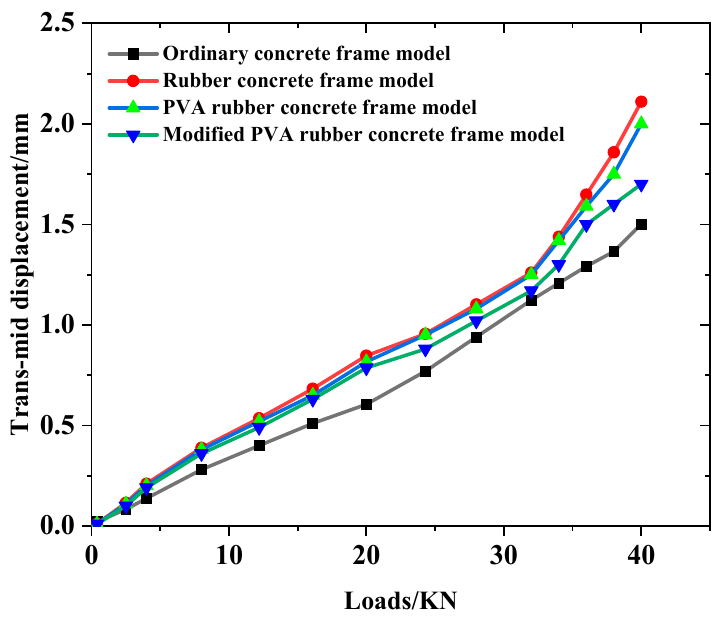
Figure 13. Relationship curve between displacement and load across four frame structures.